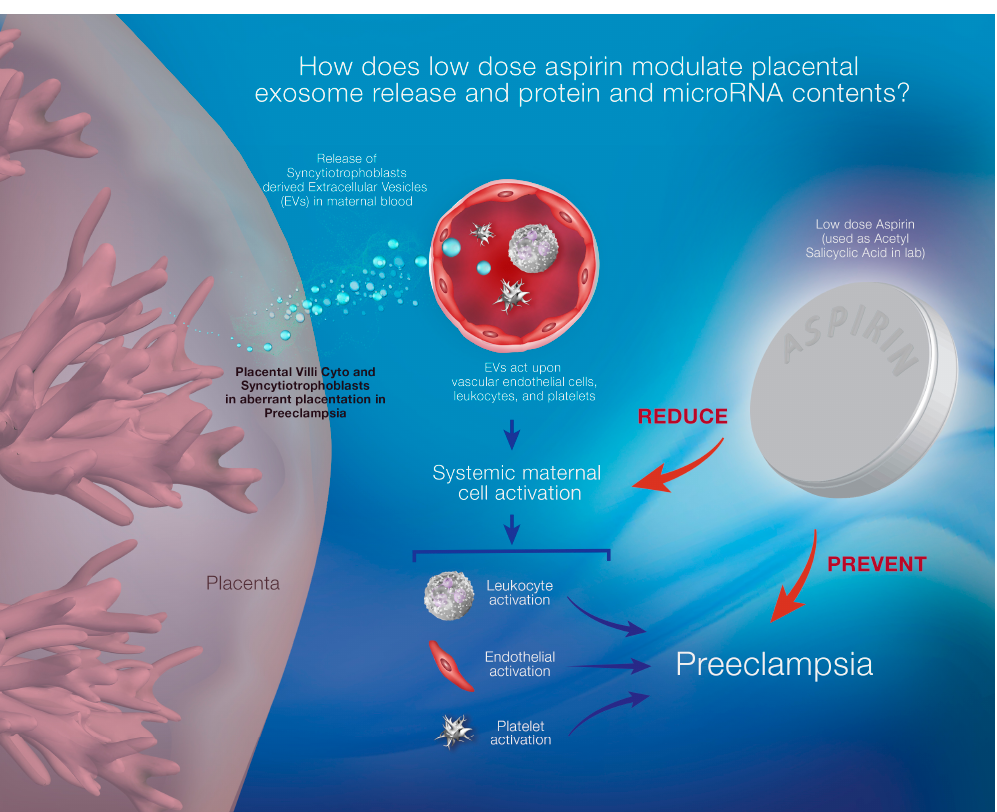
Figure 1. Diagrammatic representation of preeclampsia (PE) development pathogenesis and mechanism of prevention by low dose aspirin (LDA). In PE, syncytiotrophoblast-derived extracellular vesicles (EVs), including exosomes, are released into the maternal circulation in increased amounts due to inadequate placental vascular remodeling. These EVs activate the vascular endothelial cells, leukocytes and platelets and cause dysfunction. LDA prevents the development of PE by reducingendothelial cell dysfunction. The proposed mechanism that was investigated; acetylsalicylic acid, the crude form of aspirin, modulates trophoblast derived exosome release and changes their proteomic and microRNA contents.